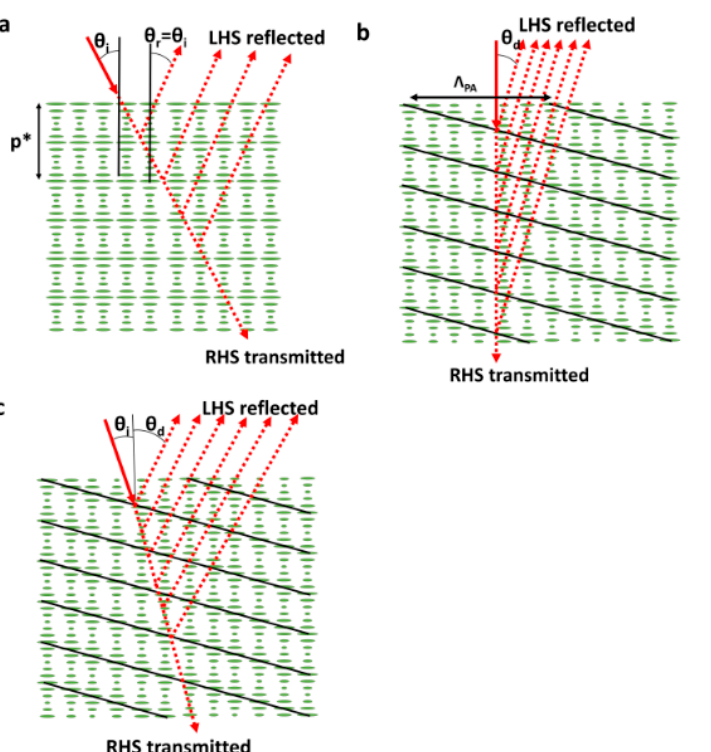
Figure 12. Variations of Volume Bragg Gratings (VBGs). ( a ) Shows simple Bragg diffraction where strong deflection occurs at an angle equal to the incident angle. ( b ) Shows a variation of ( a ) where an offset is induced in the cholesteric pitch such that the entire grating is slanted, allowing normal incidence, with off-normal reflection. ( c ) Demonstrates the effect of off-normal incidence on the tilted grating.